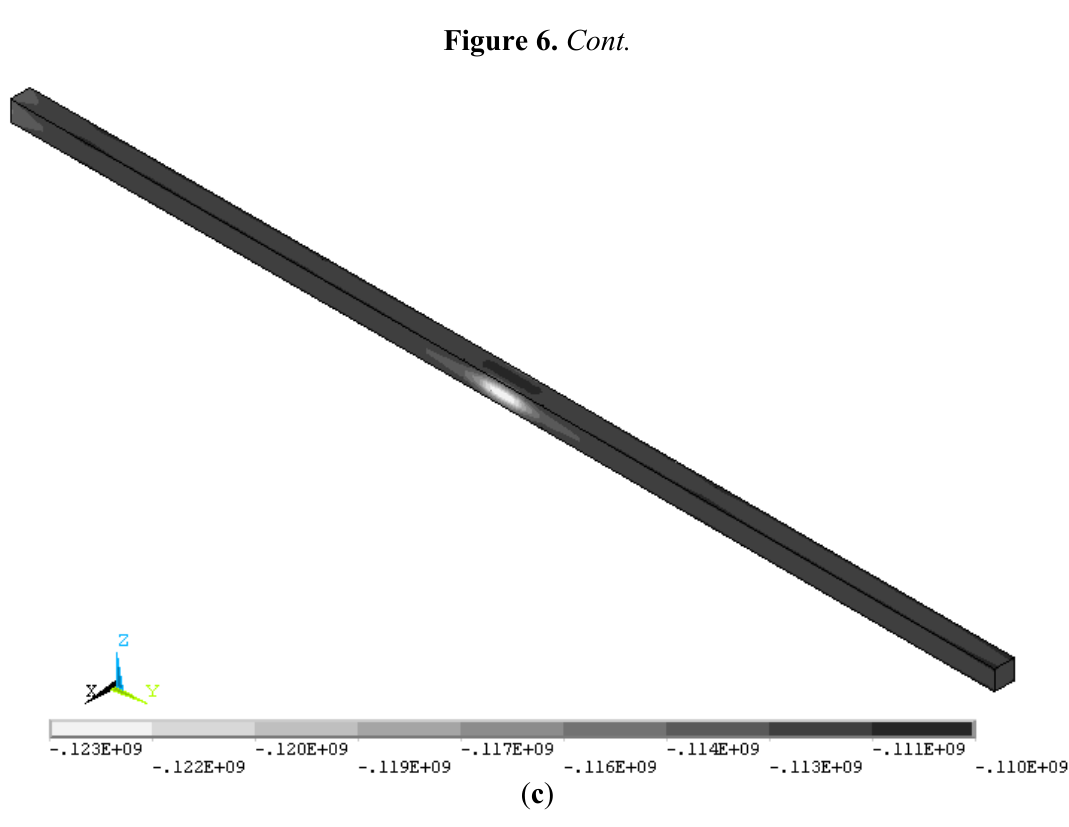
Figure 7. Strain distribution at t = 1 s. ( a ) x direction; ( b ) y direction and ( c ) z